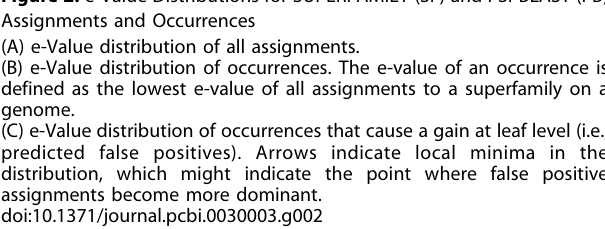
Figure 2. e-Value Distributions for SUPERFAMILY (SF) and PSI-BLAST (PB) Assignments and Occurrences (A) e-Value distribution of all assignments. (B) e-Value distribution of occurrences. The e-value of an occurrence is defined as the lowest e-value of all assignments to a superfamily on a genome. (C) e-Value distribution of occurrences that cause a gain at leaf level (i.e., predicted false positives). Arrows indicate local minima in the distribution, which might indicate the point where false positive assignments become more